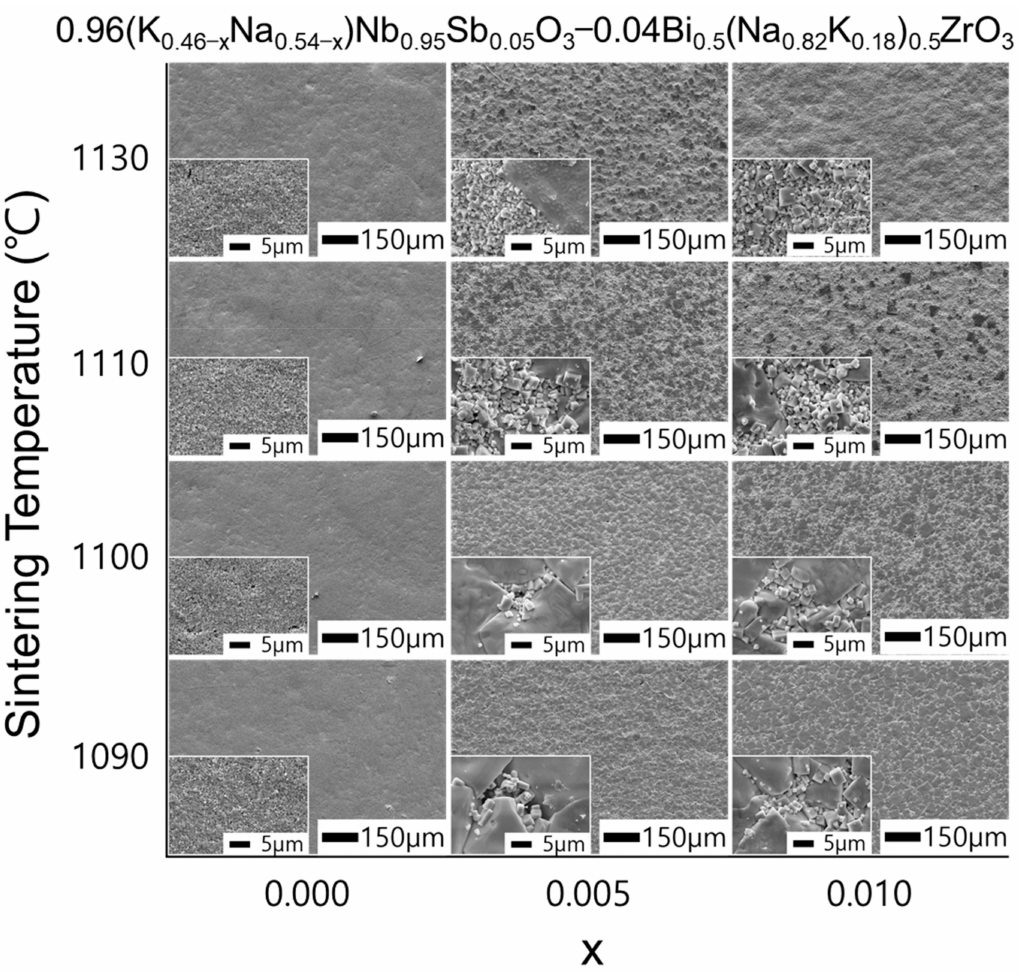
Figure 5. SEM images showing the microstructural evolution of 0.96(K 0.46 − x Na 0.54 − x )Nb 0.95 Sb 0.05 O 3 - 0.04Bi 0.5 (Na 0.82 K 0.18 ) 0.5 ZrO 3 ceramics sintered in the temperature range from 1090 to 1130 ◦ C for 4 h. Insets show magnified SEM images for each